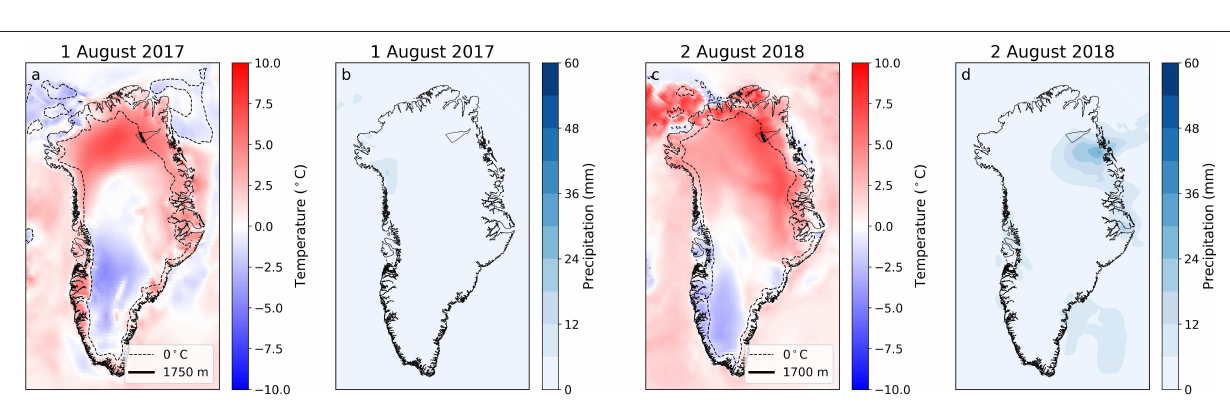
FIGURE 5 | ERA5 reanalysis data for selected dates with high surface melt. 2 m air temperature anomaly of 1 August 2017 vs. the monthly average of July 2017 is shown in (a) , together with the 0 ◦ C isotherm and the maximum altitude of surface melt on 1 August 2017 (1750 m). Cumulated hourly precipitation of 1 August 2017 is shown in (b) . Panels (c,d) show the same as (a) and (b) but for 2 August 2018. The polygon framed by a black solid line marks the area used for the backscatter analysis shown in Figure 2b